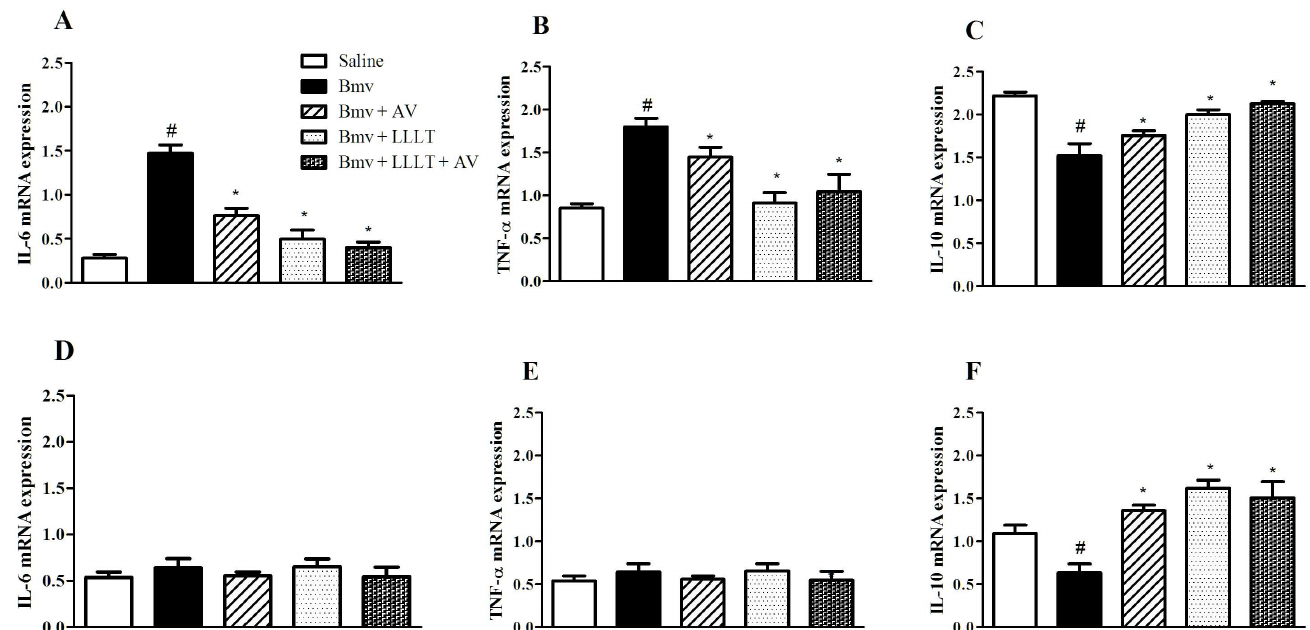
Fig 3. Effect of LLLT on IL-6 (A and D), TNF- α (B and E) or IL-10 (C and F) mRNA expression. mRNA levels of IL-6, TNF- α or IL-10 were evaluatedby RT-PCR on samples from foot pad (A, B and C) or spinal cord (D, E and F) of mice injected intraplantarwith saline or Bmv (1 μ g) and treated or not with LLLT at 685 nm or antivenom (AV) or a combination of LLLT and AV were collected 6 h after treatments. Experiments were performed in triplicates. Data are expressedas means ± SEM of 5 animals from each group. Statistically significant differences vs. saline ( # p < 0.05) or vs. Bmv ( * p < 0.05) are